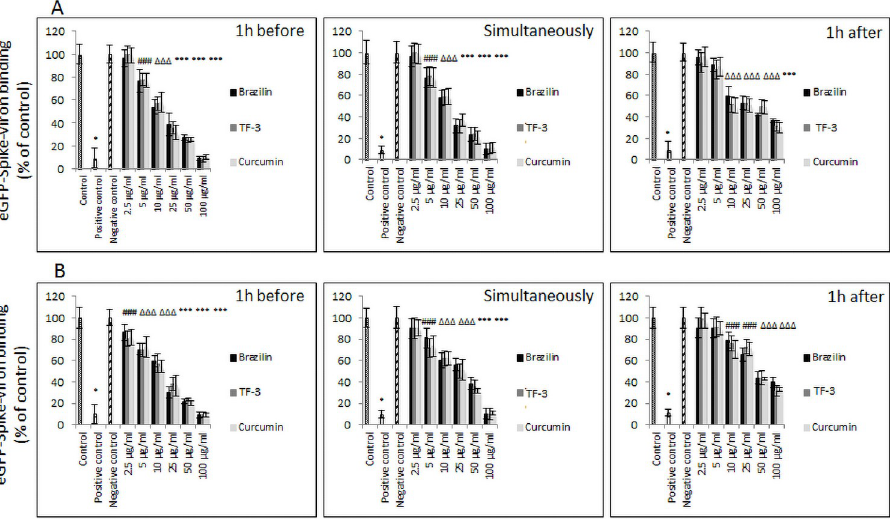
Fig 2. Binding of SARS-CoV-2 pseudo-virion to human ACE2 receptor. (A) Dose-dependent binding of SARS- CoV-2 spike protein-encapsulated pseudo-virions to A549 cells stably overexpressing human ACE2 receptor evaluated after 1h incubation. (B) Dose-dependent binding of SARS-CoV-2 spike protein-encapsulated pseudo-virions to A549 cells stably overexpressing hACE2 receptor evaluated after 3h incubation. Data are presented as % of control ± SD; control– 0.025% DMSO, positive and negative controls were provided by the manufacturer; TF-3 –theaflavin-3,3’- digallate # p � 0.05, Δ p � 0.01, � p � 0.001. https://doi.org/10.1371/journal.pone.0253489.g002 fashion, binding of SARS-CoV-2 spike protein pseudo-typed virions A549 to hACE2/A549 at non-toxic concentrations (i.e., 5.0–25 μ g/ml). Inhibition ranged from 20% to 80% when spin- inoculation was not introduced, and from 20% to 40% when spin-inoculation was introduced (Fig 3). When spin-inoculation was not applied, significant inhibition was observed from